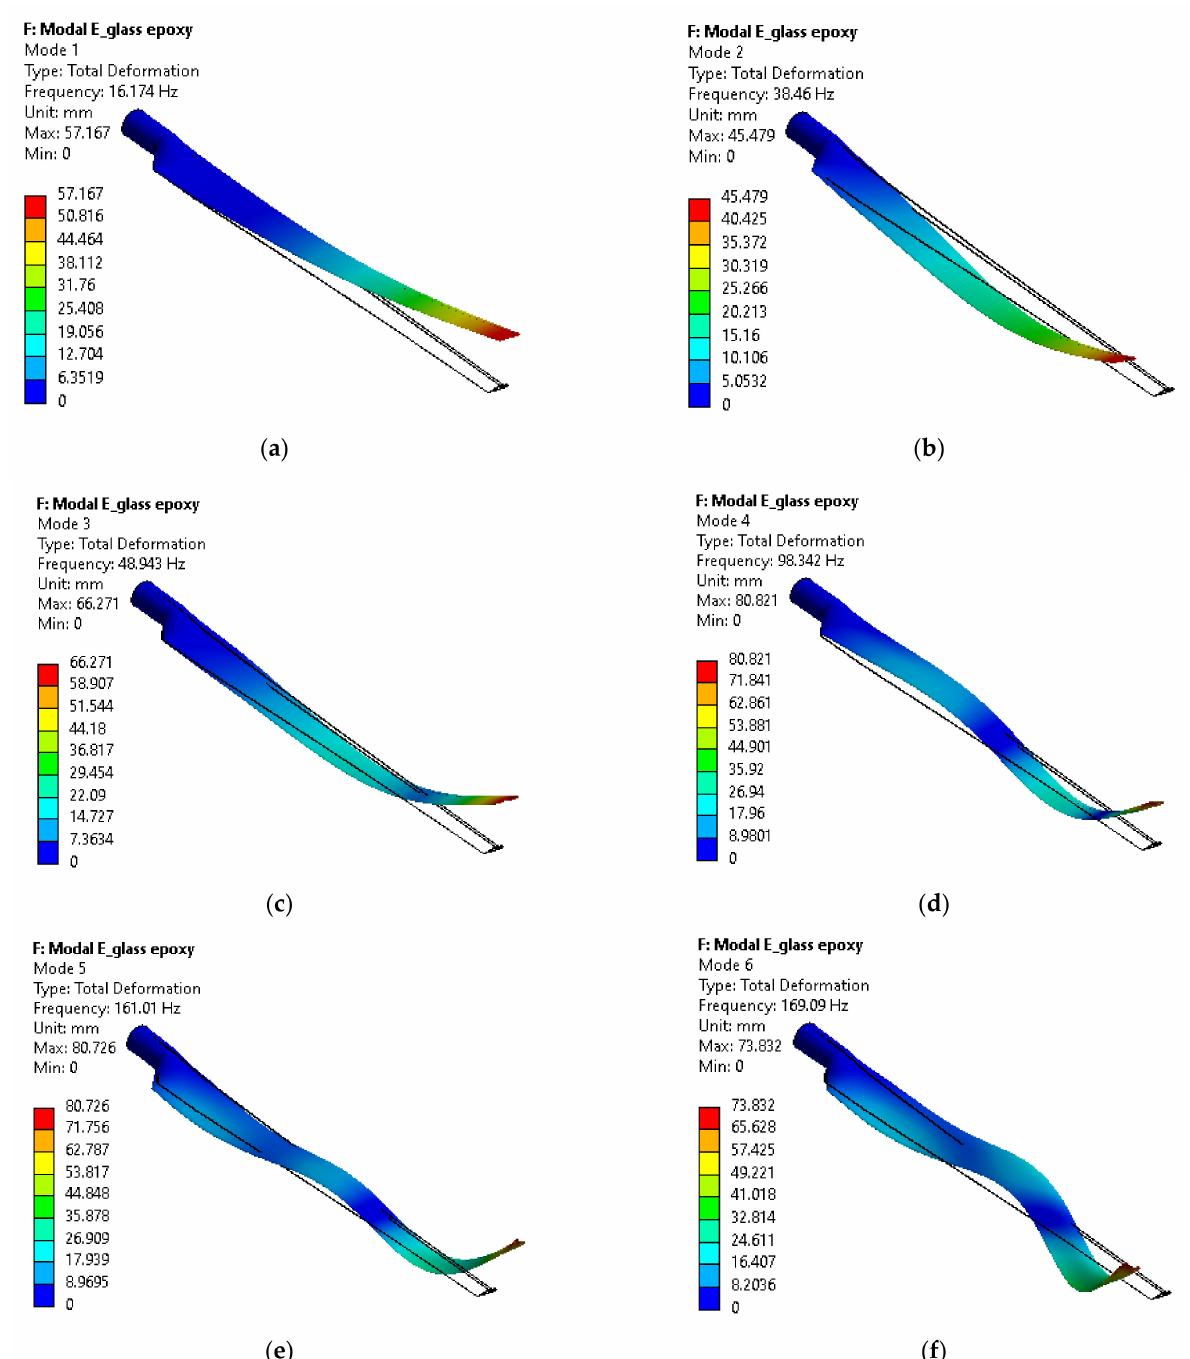
Figure 17. The first 6th mode shape of E-glass/epoxy material. ( a ) 1st mode. ( b ) 2nd mode. ( c ) 3rd mode. ( d ) 4th mode. ( e ) 5th mode. ( f ) 6th